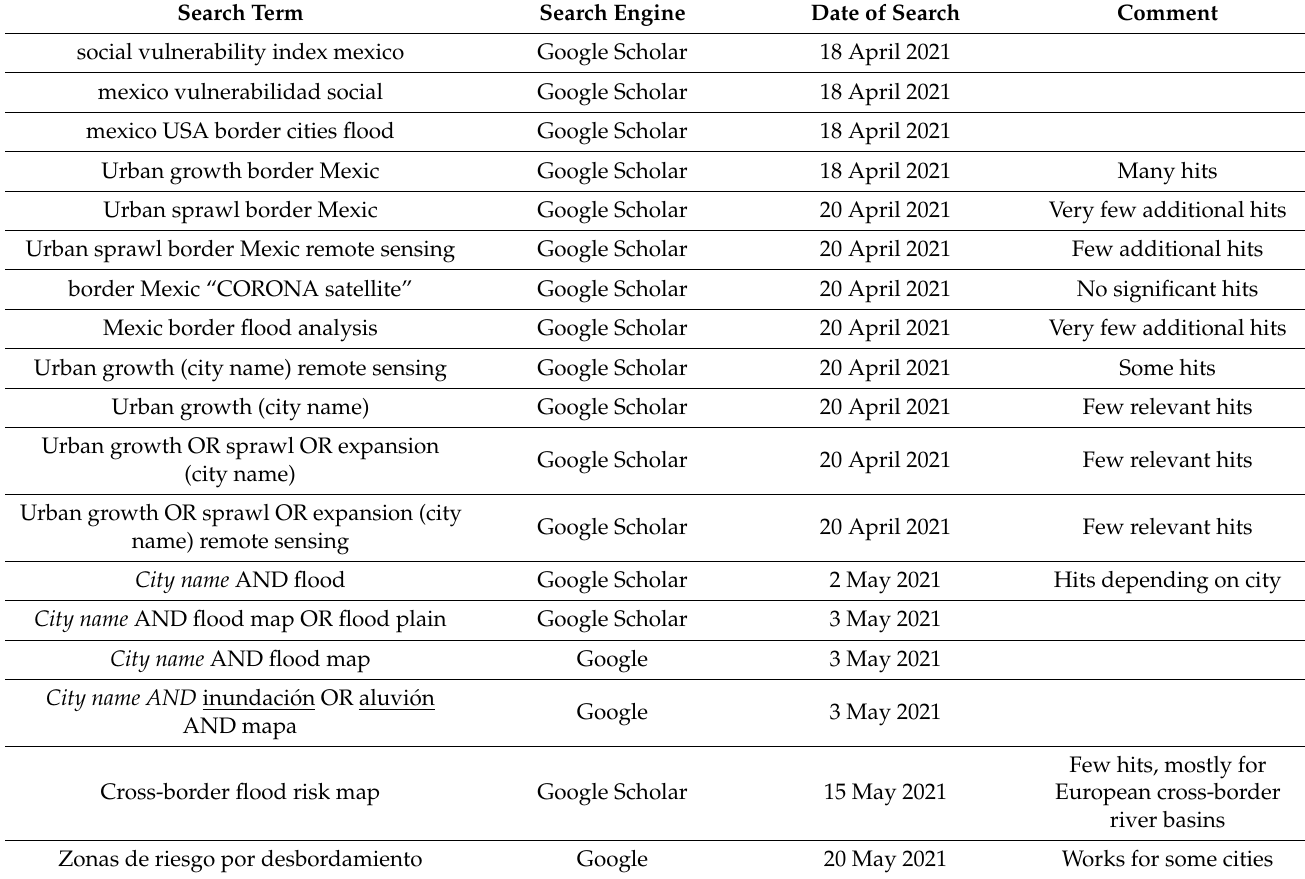
Table A1. List of search terms